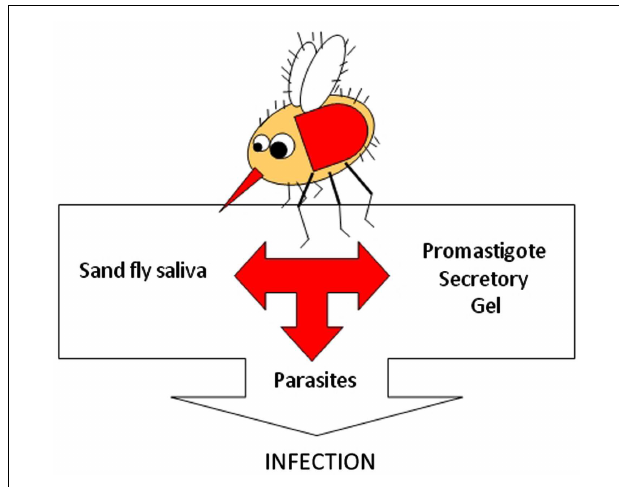
FIGURE 1 |The known components of Leishmania transmission.